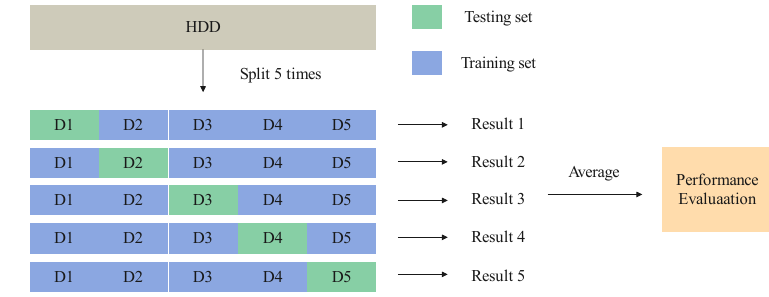
Figure 4. Graphical representation of 5-fold